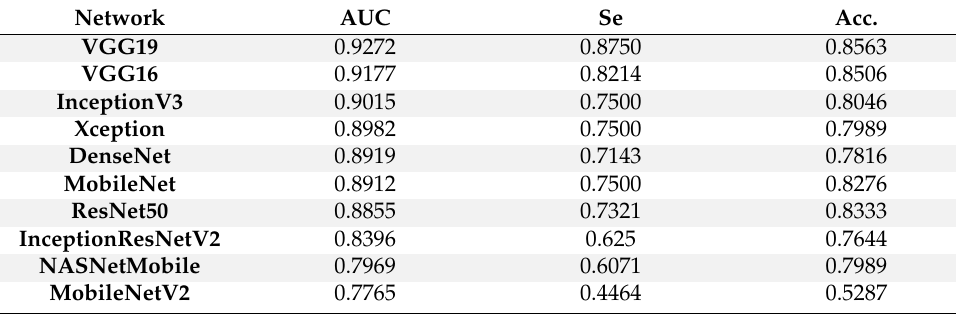
Table 5. Evaluation of networks using the Madrid and Zaragoza test